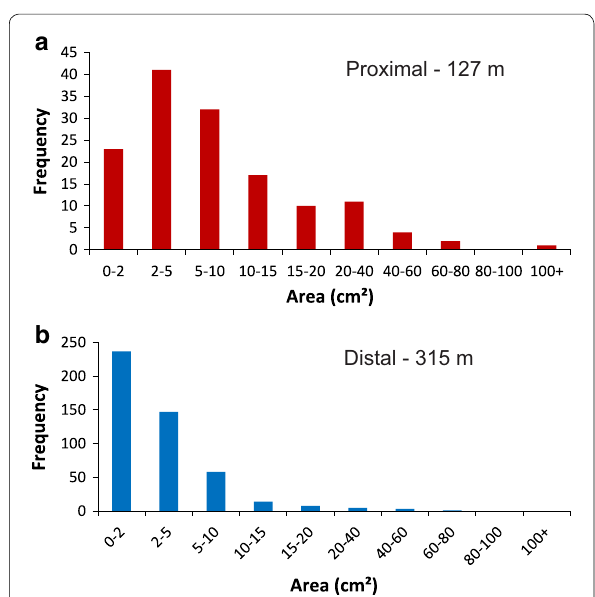
Fig. 12 Size distribution of clasts at sites proximal and distal to the vent. a Proximal site 10–127 m from the vent and b distal site 33–315 m from the closest